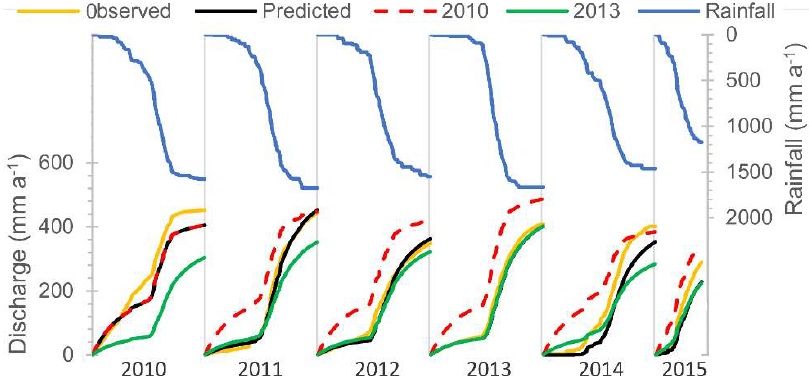
Figure 5. Cumulative discharge for the Tikur-Wuha watershed for the period of 2010–2015. The blue lines are the observed data. The black lines represent the simulated discharge with the parameter set calibrated for the various periods. The broken red line represents the simulated discharge with the parameters set calibrated for 2010 and the green line indicates 2013. The parameter values are given in Table 3.